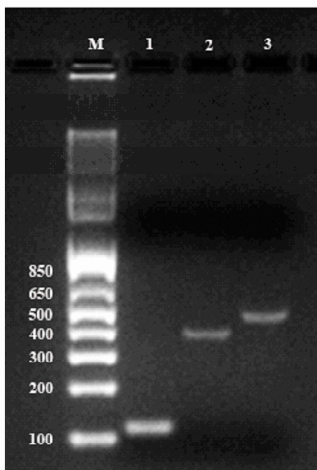
Figure 3. Verification of PCR products on 2% agarose gel electrophoresis along with the 1 Kb Plus DNA Ladder (M). Amplification of each mRNA is shown: lane 1, β -actin (109 bp); lane 2, cycloartenol synthase (364 bp); lane 3, β -amyrin synthase (445 bp).